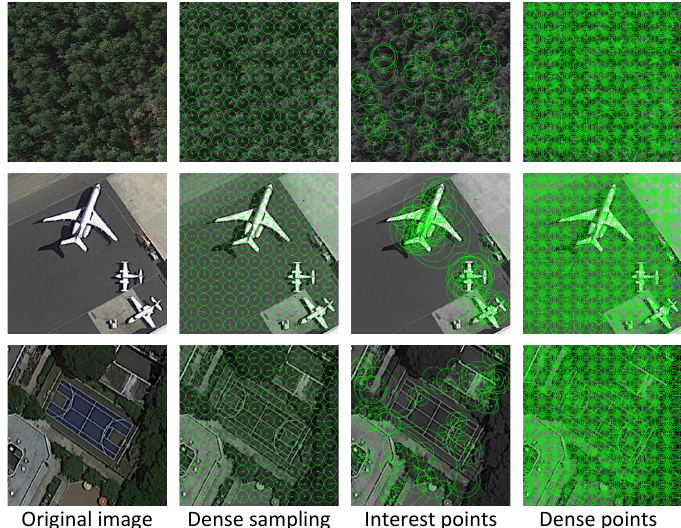
Figure 5. Scene recognition with dense sampling, sparse interest points and the proposed dense interest